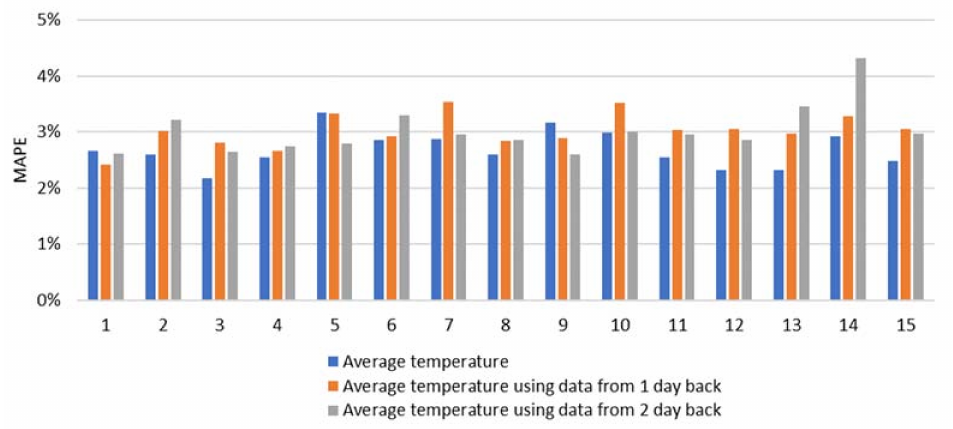
Figure 7. MAPE error results for the models using the 24-h average